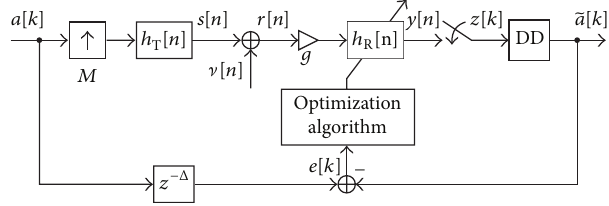
Figure 5: Communication system optimisation. Transmitted sym- bols are compared against the received ones to design the receiver filter.